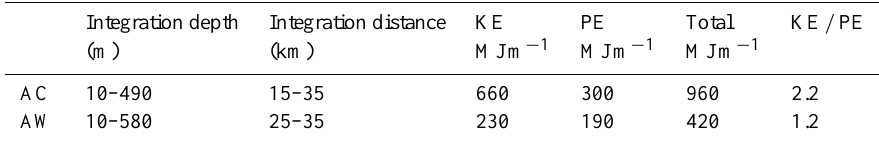
Table 2. Total energy in the mode-2 waves. Integration